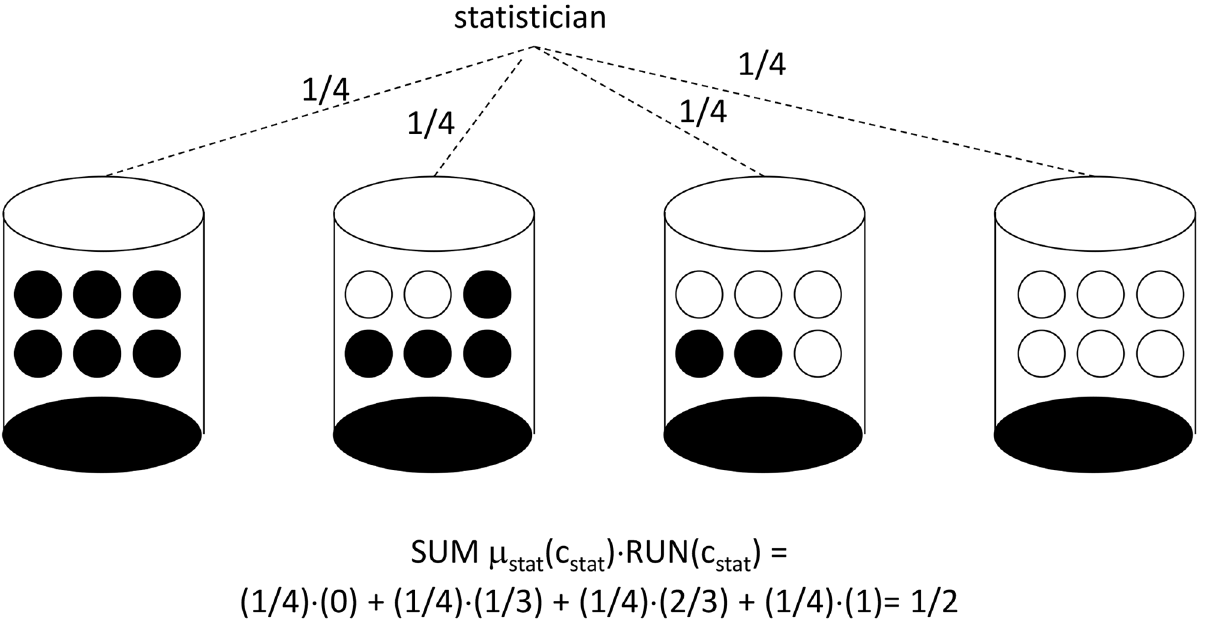
Fig 4. Urn Design for Run-Reversal Equilibrium with 6 Clinics. An urn is selected according to the probabilities shown, and then balls are drawn without replacement until the urn is empty. A run in treatment imbalance is assigned for a clinic when a white ball is drawn. A reversal in treatment imbalance is assigned for a clinic when a black ball is